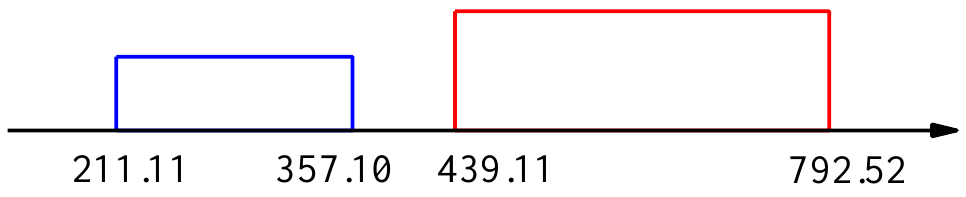
Figure 5. Comparison of stress due to dynamic bending loading and the ultimate tensile strength at interval (unit: MPa).